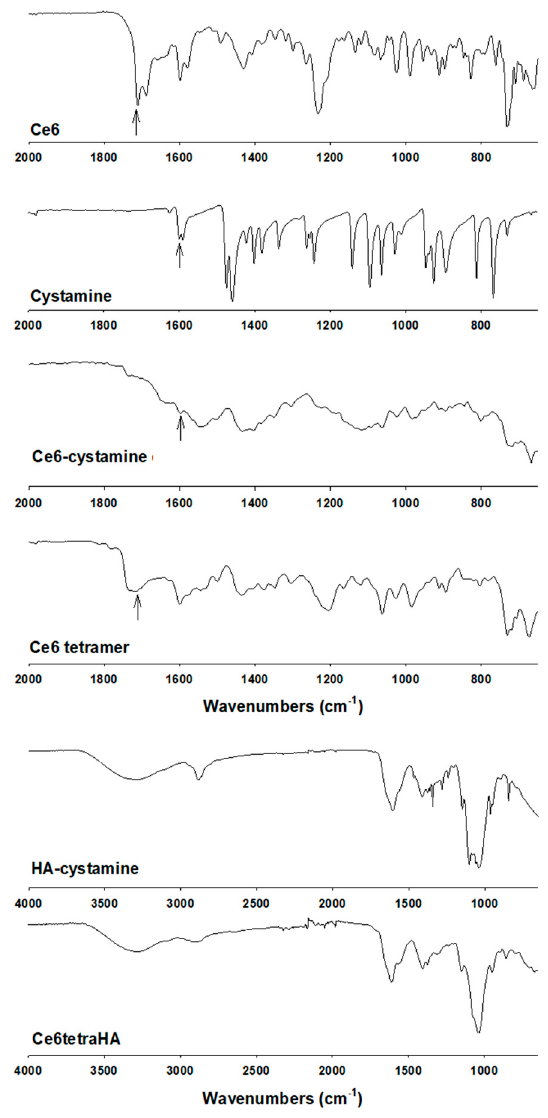
Figure 3. FT-IR spectra of Ce6tetraHA.